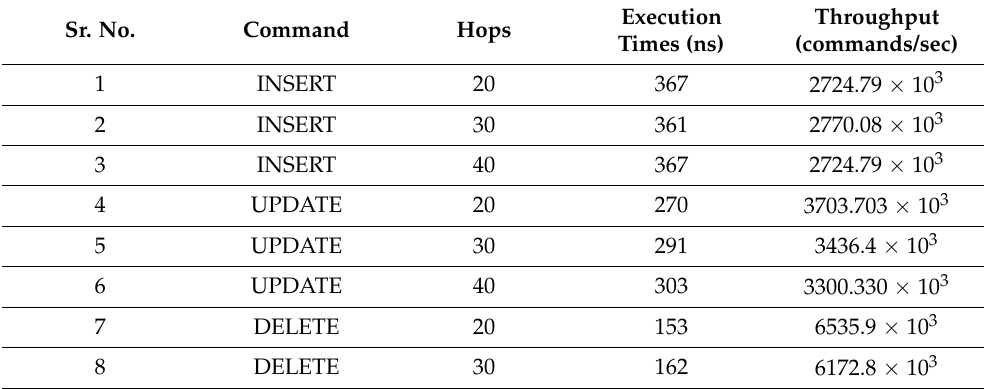
Table 6. Throughput of various